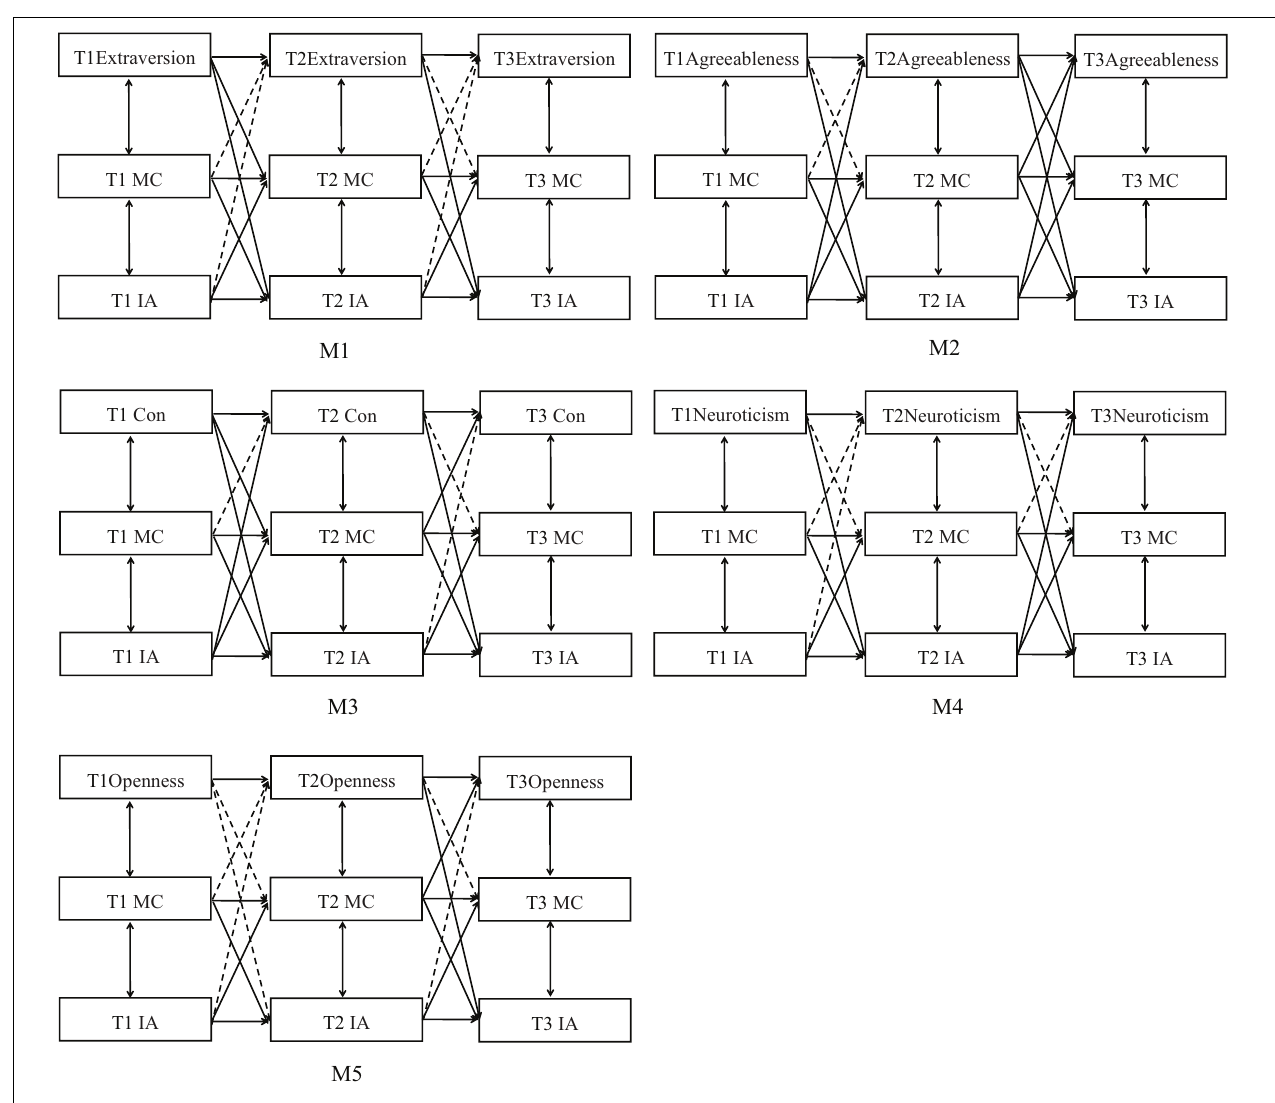
FIGURE 1 | Cross-lagged associations among the Big Five personality traits, maladaptive cognitions, and Internet addiction. Thick lines represent significant paths, and dashed lines represent non-significant paths.